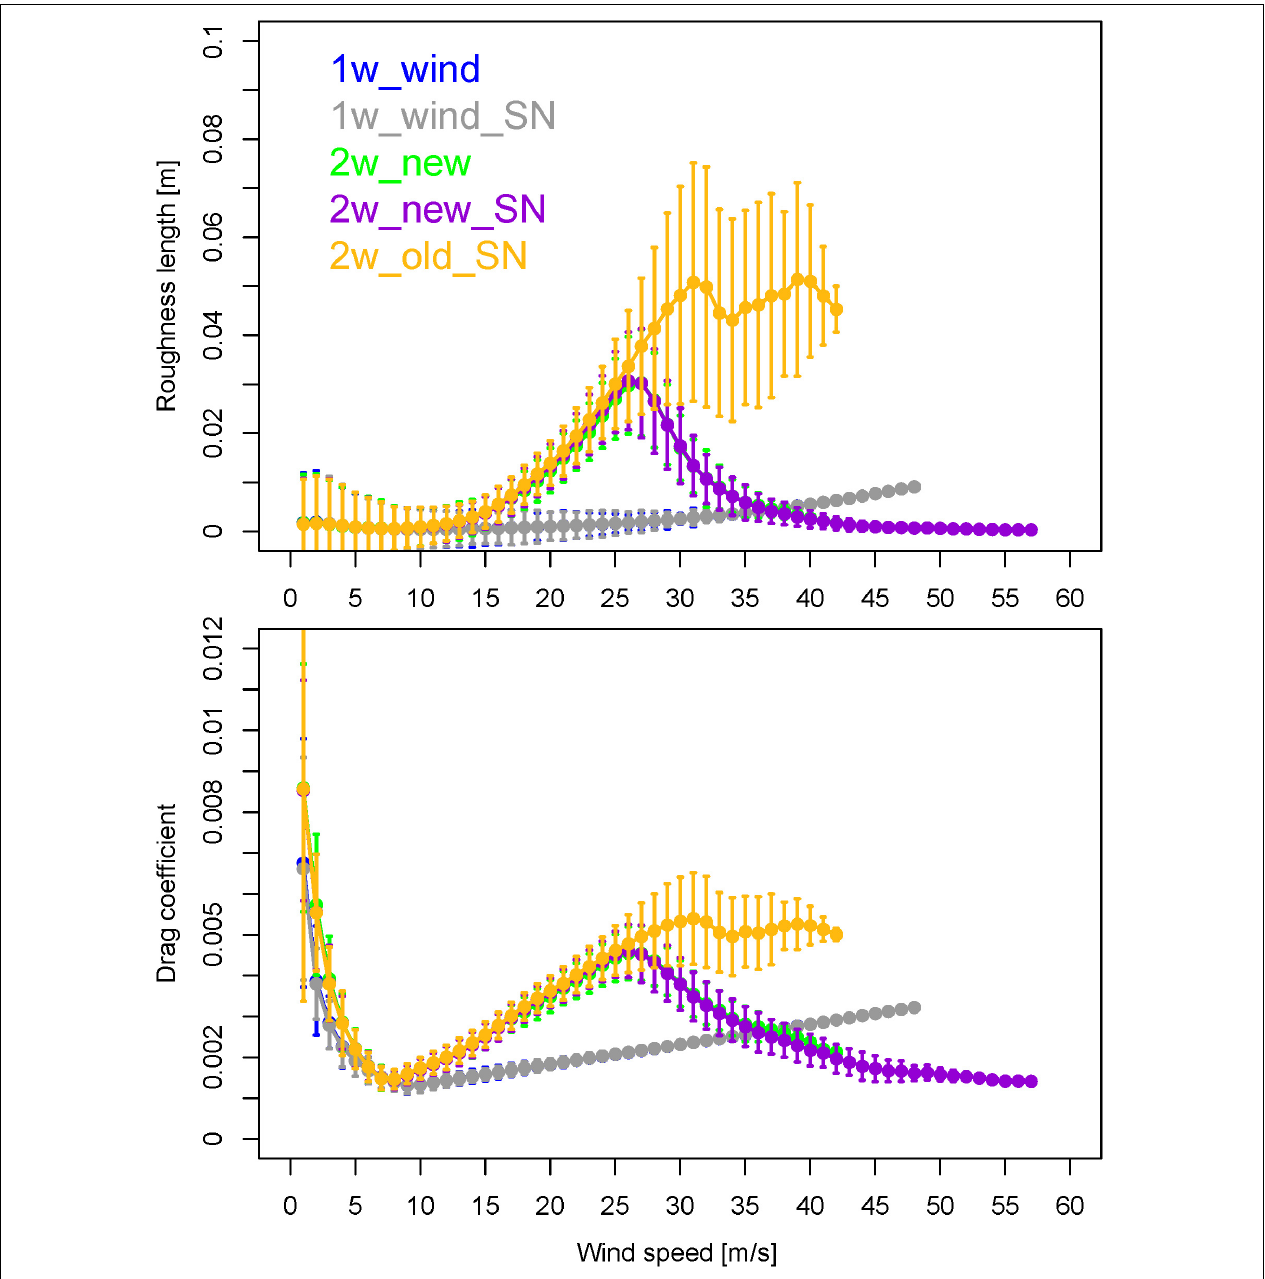
FIGURE 2 | The relationship between wind speed and (upper panel) roughness length, and (lower panel) drag coefficient during Typhoon Lingling (2–7 September 2019) over the coupling domain for the five simulations. Error bars represent one standard deviation for each bin.